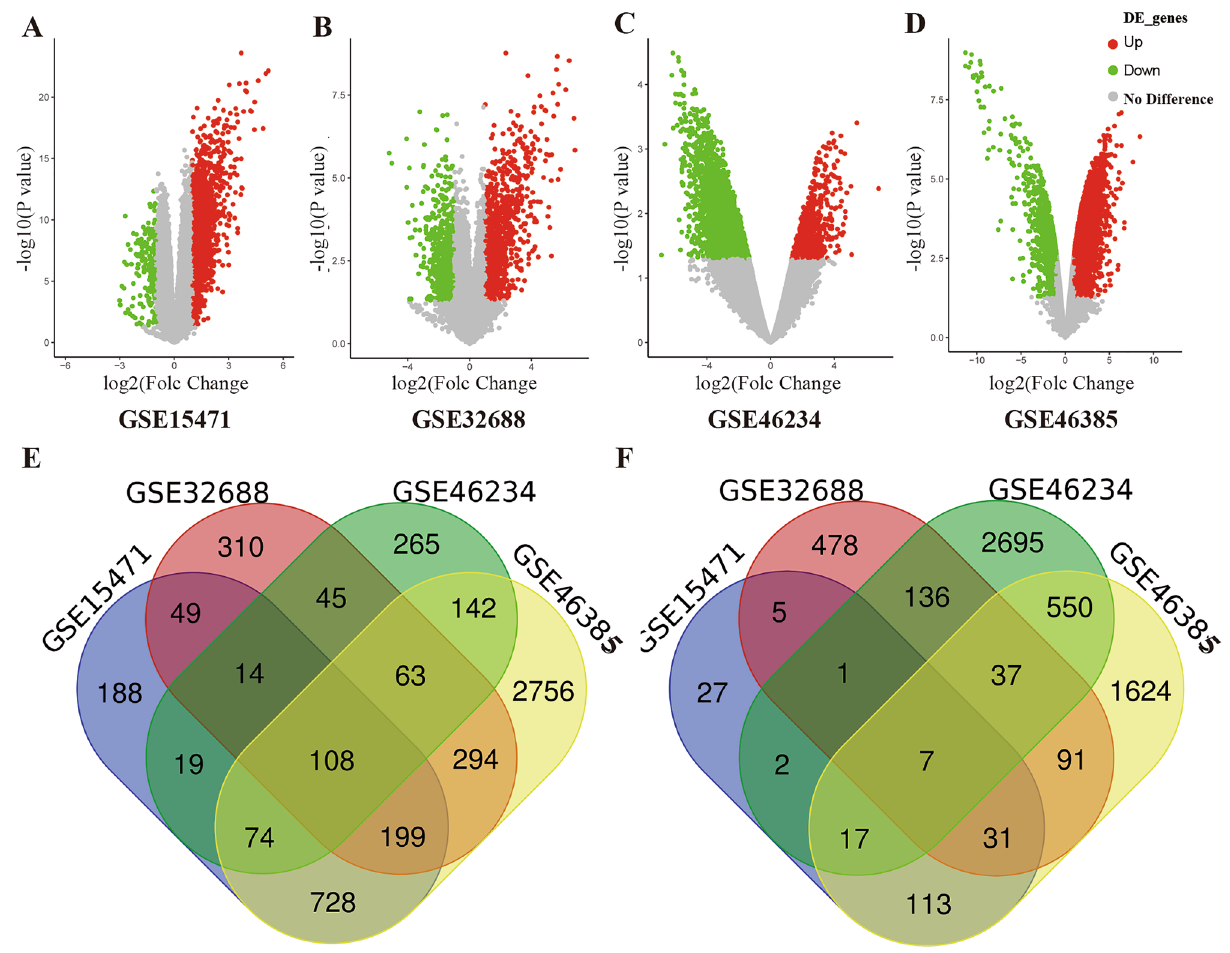
Figure 1. Selection of 115 common DEGs from three datasets (GSE15471, GSE32688, GSE46234 and GSE46385) ( A–D ). Volcano plot of DEGs from the three datasets; ( E ) 108 DEGs are up-regulated (logFC ≥ 1); ( F ) 7 DEGs are down-regulated (logFC ≤